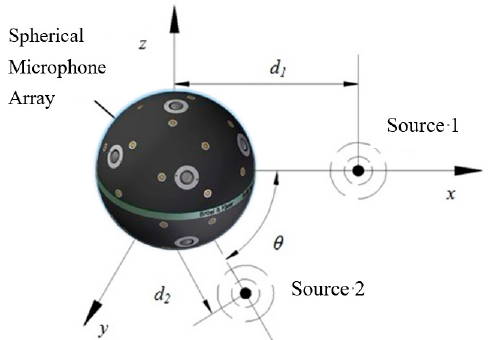
Figure 7. Diagram of two monopole sound field. Spherical microphone array is located in the origin. Two monopole sources are located in the x – y plane: one is on the x -axis, and the second monopole source is located on the first quadrant which has the same standoff distance from the spherical array with the first one—intersection angle between the two source is θ .